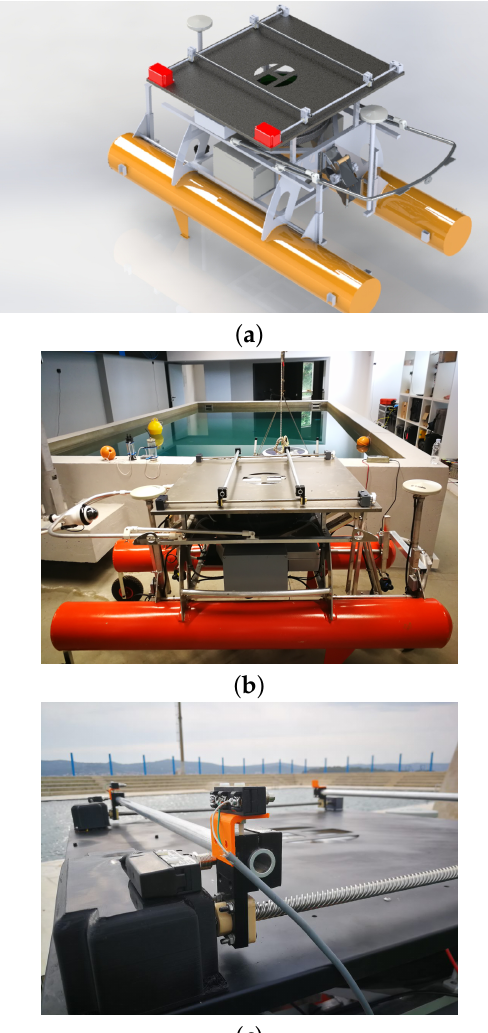
Figure 11. Platform for landing the LAAR on ASV Korkyra. ( a ) SolidWorks model rendering. ( b ) Constructed prototype version for laboratory testing, mounted on the ASV. ( c ) Stepper motors (in black boxes) and four integrated contact switches for the control system of the